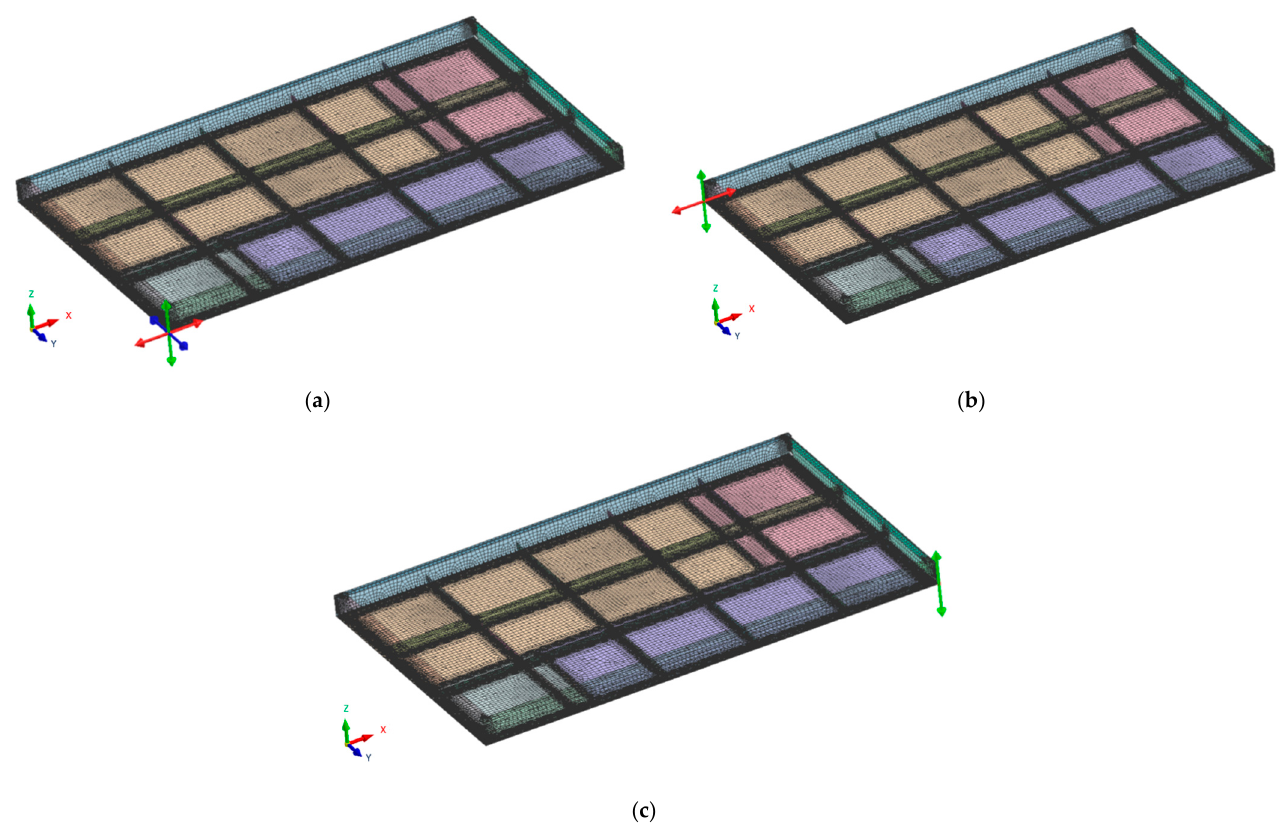
Figure 7. Diagrams of restraint boundary conditions after panel welding; ( a ) no node displacement in the X, Y, and Z directions, ( b ) no node displacement in the X and Y directions, and ( c ) no node displacement in the Y direction.